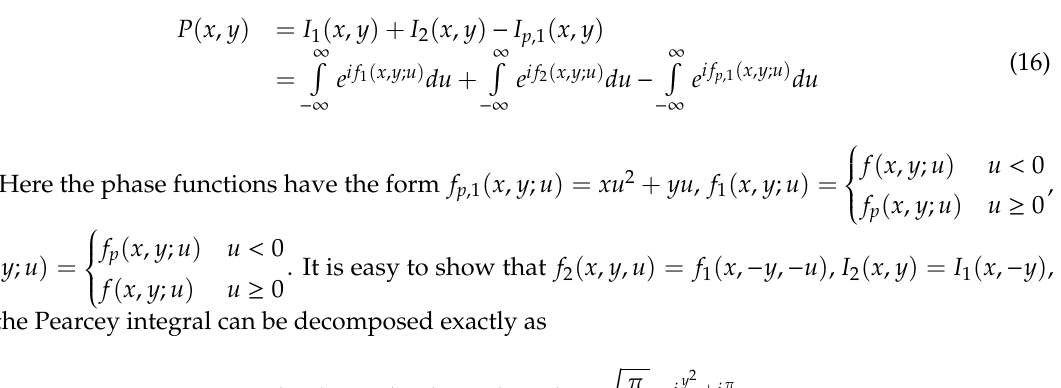
Table 2. Comparison values of ( , ) P x y and approximate function